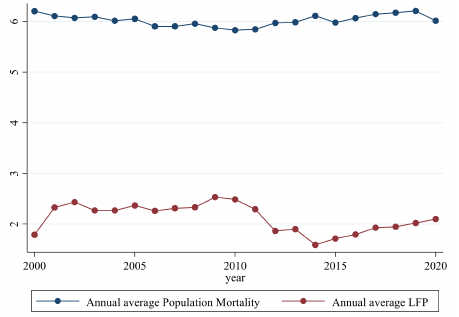
Figure 2. Annual average trend between LFP and population mortality. (Source: China Statistical Yearbook (2001–2021)).